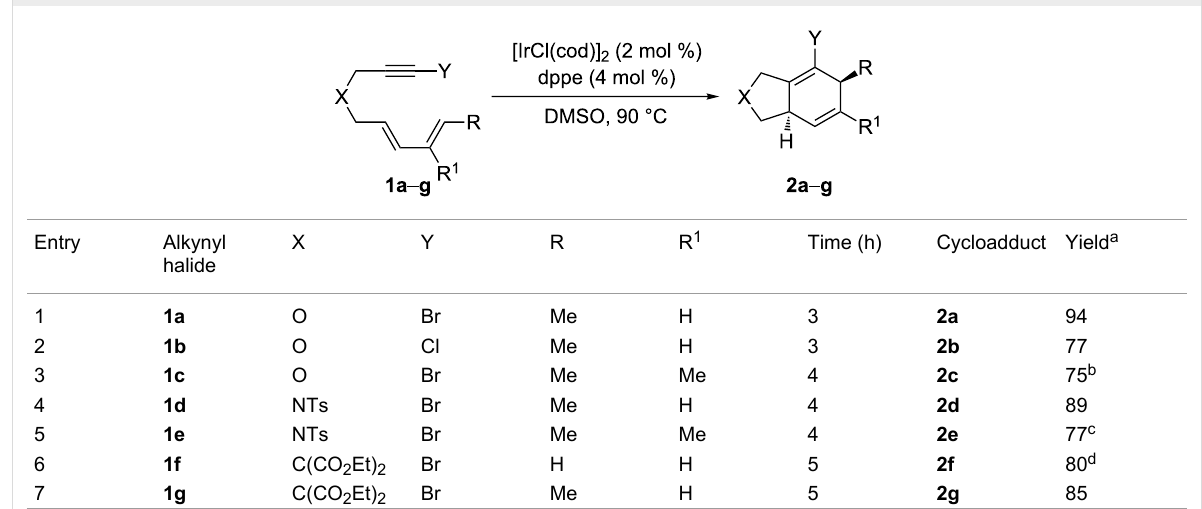
Table 3: [IrCl(cod)] 2 /dppe-catalyzed [4 + 2] cycloadditions of various alkynyl